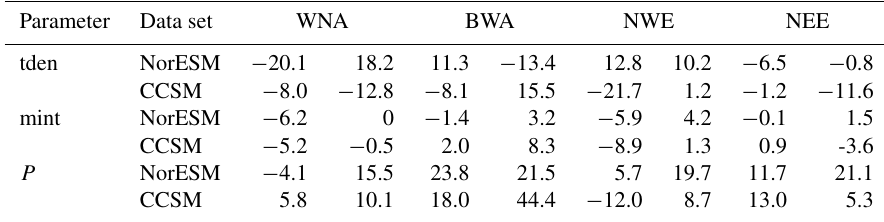
Table 3. Changes of track density (tden; first row), mean intensity (mint; second row) and precipitation ( P ; third row) over September and December for 2074–2100 relative to 1979–2005 following the RCP8.5 scenario in NorESM and CCSM in four North Atlantic and North Pacific storm track regions. The regions are western North America (WNA; 50–58 ◦ N, 125–137 ◦ W and 58–62 ◦ N, 136–155 ◦ W), Bering and western Alaska (BWA; 55–72 ◦ N, 155–180 ◦ W), northwestern Europe (NWE; 55–65 ◦ N, 15 ◦ W–15 ◦ E) and northeastern Europe (NEE; 65– 75 ◦ N, 10 ◦ W–50 ◦ E). First number within each column denotes change in September; second number within each column denotes change in December. Unit is %.